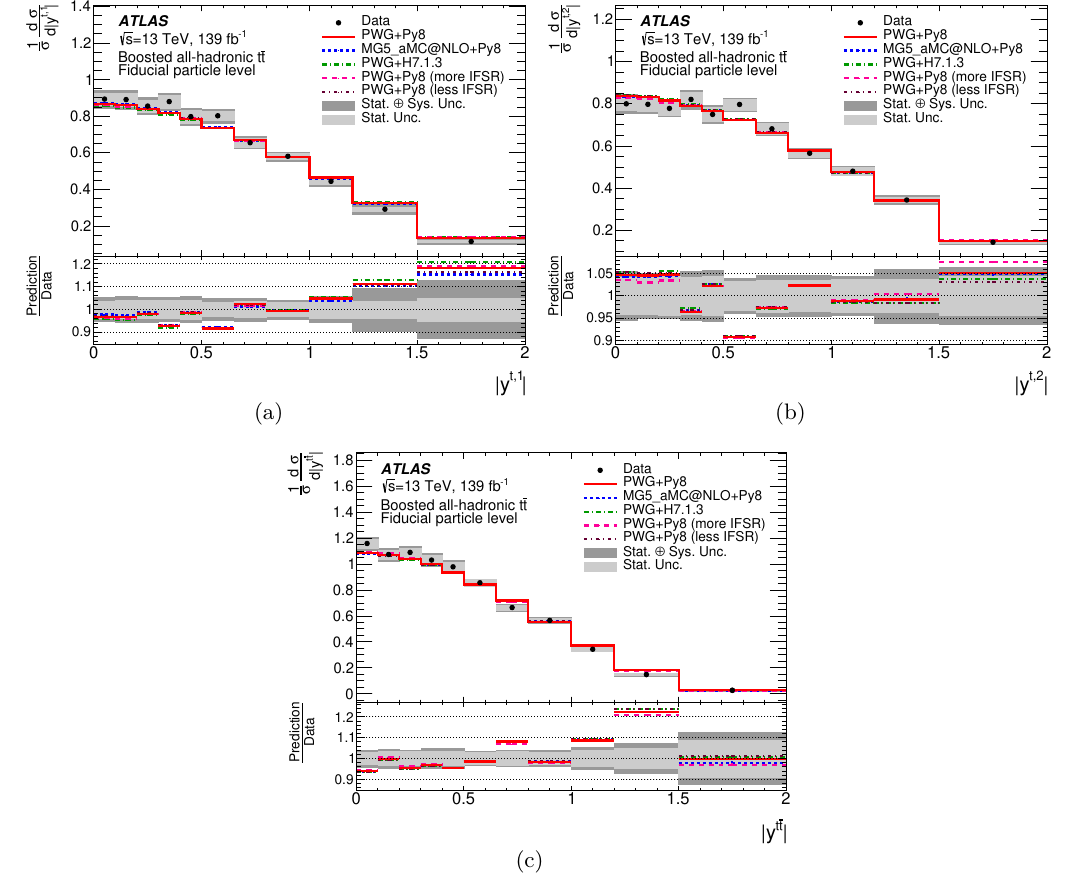
Figure 11 . Normalized particle-level fiducial phase-space differential cross-sections as a function of the absolute value of the rapidity of (a) the leading top-quark jet, (b) the second-leading top-quark jet, and (c) the t ¯ t system. The dark and light grey bands indicate the total uncertainty and the statistical uncertainty, respectively, of the data in each bin. Data points are placed at the centre of each bin. The Powheg+Pythia 8 MC sample is used as the nominal prediction to correct the data to particle